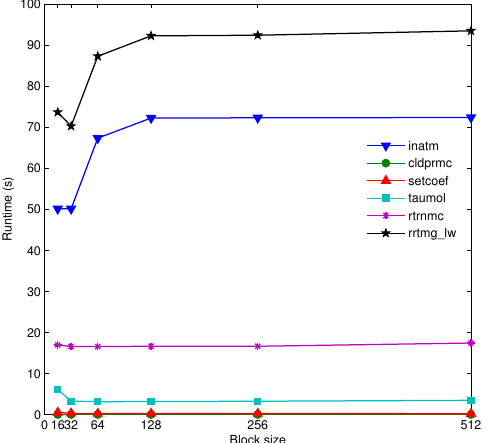
Figure 8. Run-time of the 2-D G-RRTMG_LW on one K40